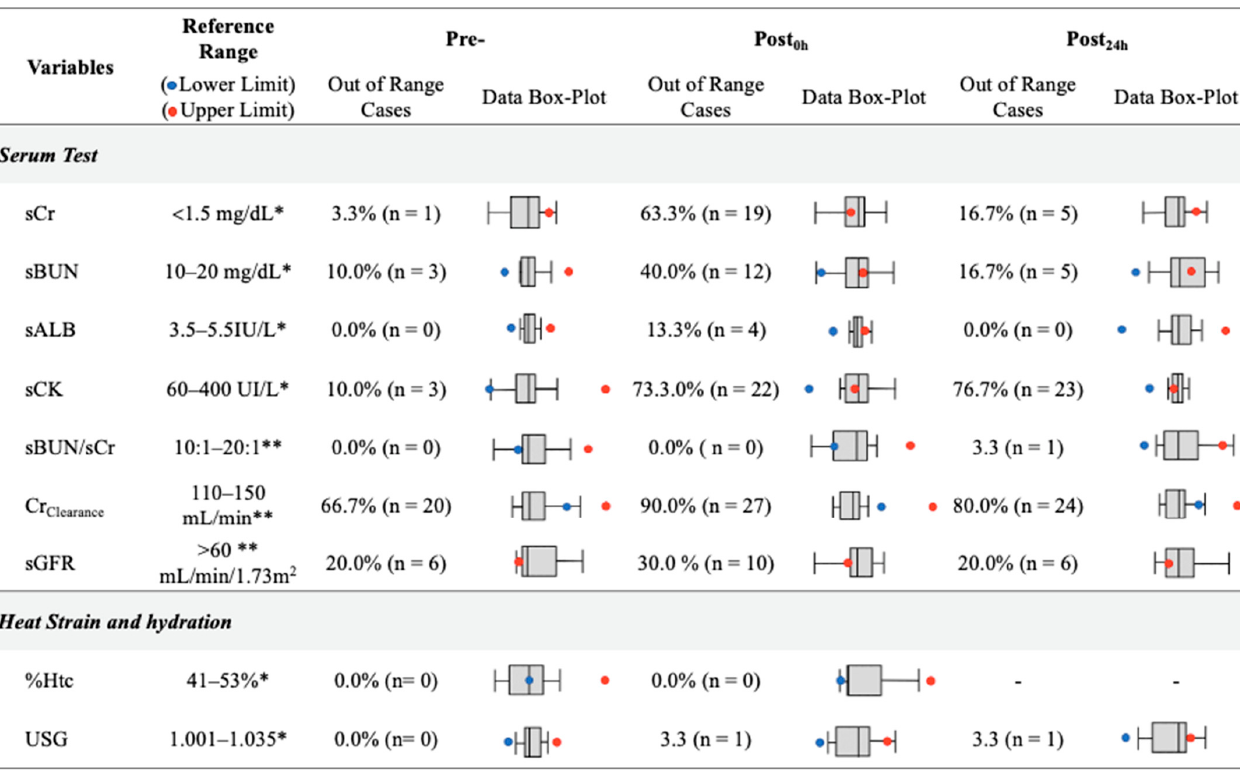
Figure 2. Cases out of reference ranges in serum, heat strain and hydration variables by measurement timepoints. Reference Ranges: * [32], ** [33]. sCr = creatinine, sCK = creatine kinase sBUN = blood ureic nitrogen, sALB = albumin, eGFR, estimated glomerular filtration rate, Cr Clearance = creatinine clearance, USG = urine specific gravity, Htc = hematocrit.